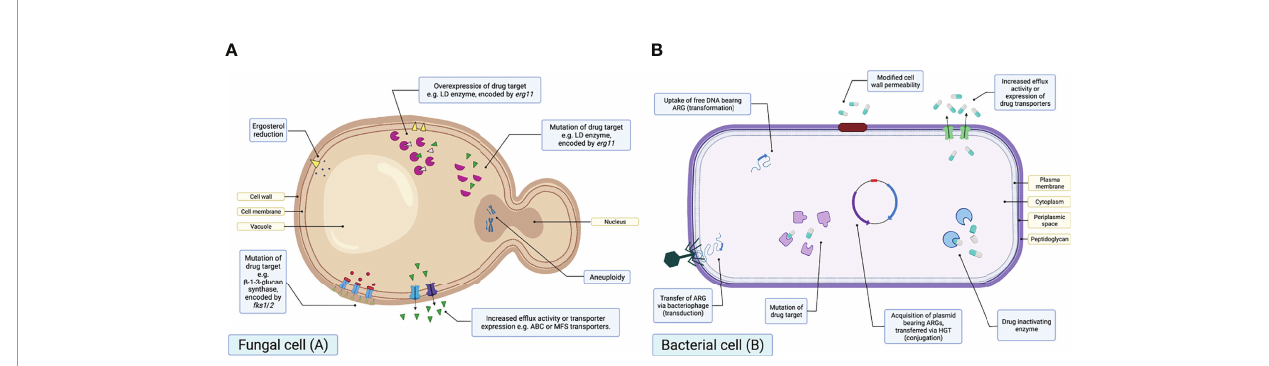
FIGURE 3 | Schematic diagrams illustrating the known mechanisms of antifungal drug resistance in a fungal cell (A) and antibacterial resistance in a bacterial cell (B) . Created